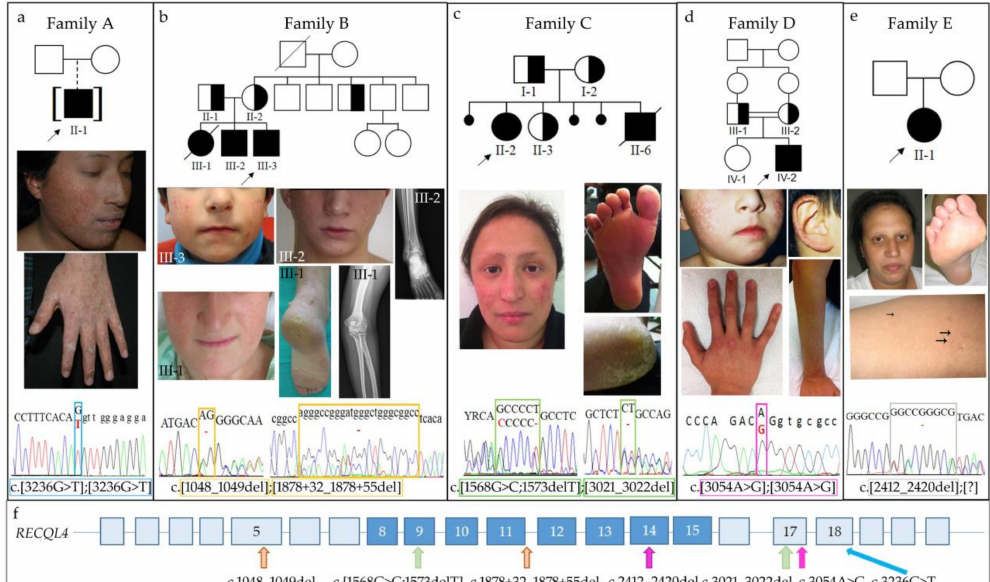
Figure 1. Clinical and molecular characterization of the five (A, B, C, D, E) RTS families. For each family, pedigree is furnished at the top, pictures of the major features in the middle and electropherograms of RECQL4 pathogenic variants in the bottom panels. ( a ) Patient #29 (family A) at age 16y: poikiloderma on face and hand, sparse eyebrows, hyperkeratotic areas on the knuckles and onychodystrophy can be observed. The homozygous c.3236G>T transversion in exon 18 is squared in blue. ( b ) Facial poikiloderma of the living siblings of family B, III-3 (#39) and III-2 at 5 and 19 years, respectively; right ankle radiography of III-2 showing a lytic focal eccentric lesion (21 × 20 × 40 mm) with “bubble” pattern and geographical margins on the side of the distal epiphyseal-metaphyseal region of the tibia. Facial poikiloderma and severe plantar hyperkeratosis of the deceased elder sister III-1 at 23y and left elbow radiography of III-1 showing a lytic lesion in the olecranon with permeative appearance and ill-defined contours with neoplastic appearance of bone matrix. The sibship c.1048_1049del in exon 5 and c.1878+32_1878+55del in intron 11 variants are squared in orange. ( c ) Patient #42 (family C): poikiloderma, sparse eyebrows and absent eyelashes can be appreciated on the face; notable plantar hyperkeratosis, in particular on the heel, is observed. Exon 9 c.[1568G>C;1573delT] and exon 17 c.3021_3022del alterations are squared in green. ( d ) Patient #19 (family D): poikiloderma on cheeks and ear (age 5y); poikiloderma on forearm and keratoderma over the phalangeal joints can be seen (age 16y). The c.3054A>G pathogenic variant affecting the penultimate nucleotide of exon 17 is squared in purple. ( e ) Patient #38 (family E): face image showing fine and sparse hair, eyelashes and eyebrows. Plantar hyperkeratosis and cutaneous small white papule (arrowed) on the forearm can be observed. The c.2412_2420del alteration in exon 14 is evidenced by a grey square. ( f ) RECQL4 intragenic location of the pathogenic variants is arrowed. A color-code is used to match mutations to index cases of the different families. RECQL4 helicase domain is shaded in